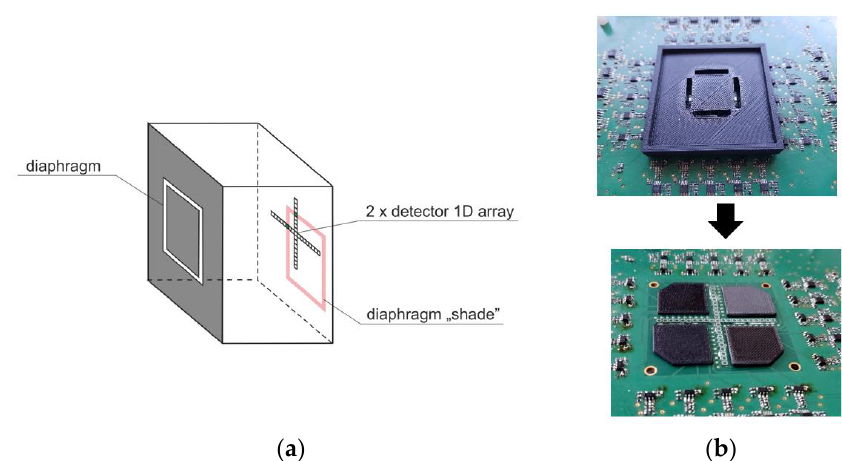
Figure 5. ( a ) Idea of a 2D configuration determined by the “shade method” for an AOI sensor. ( b ) Photos of such a sensor developed by our team (top: Sensor with the diaphragm, bottom: Diaphragm removed and 41 discrete PIN photodetectors arranged in a cross-plan).